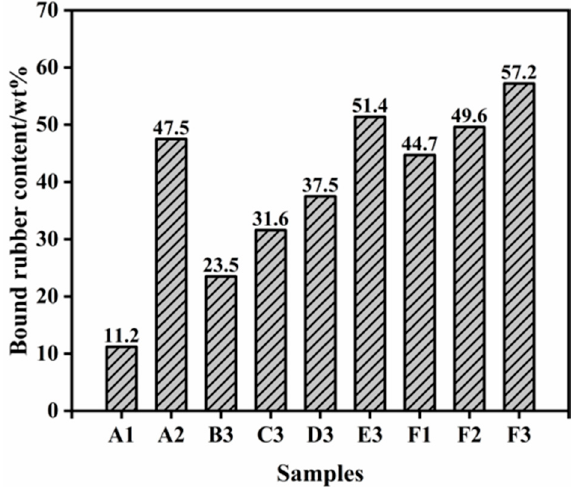
Figure 6. Bound rubber content of PS-SSBR/BR, ESSBR-SSBR/BR and TS-SSBR/BR composites.